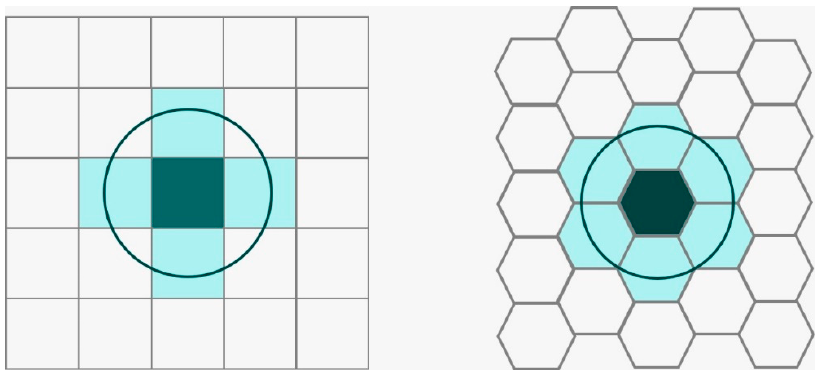
Figure A1. A rectangular grid (left side image) and hexagonal grid (right side image). Based on [62], modified.